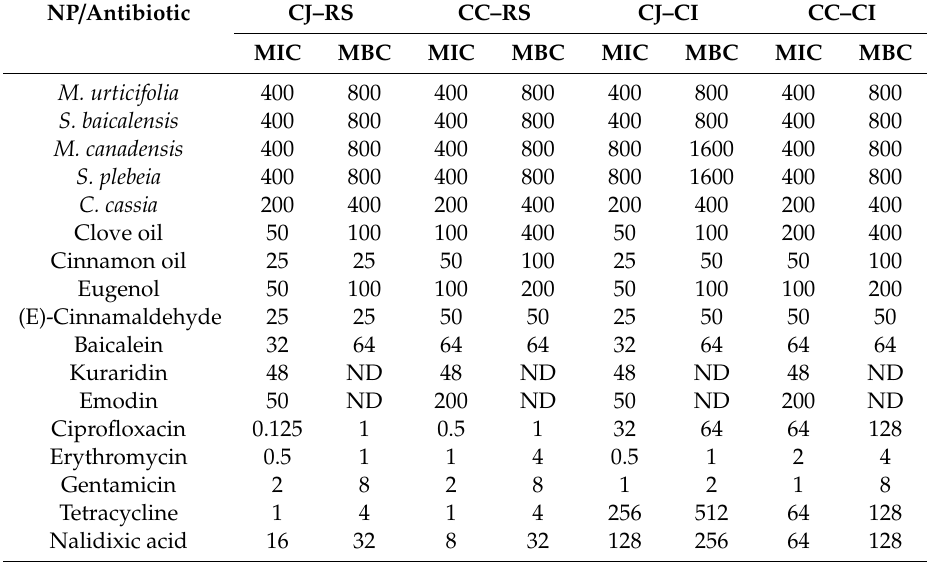
Table 2. The minimum inhibitory concentrations (MICs) and minimal bactericidal concentrations (MBCs) in µ g / mL of di ff erent natural products (NPs) and antibiotics against Campylobacter